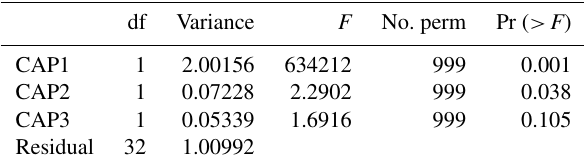
Table 2. Canonical analysis of principal coordinates (CAP) axis sig- nificance against covariates. Permutation tests assessing the signifi- cance of each constrained axis in CAP using the covariates f CO 2 , P and Si as constraints upon community